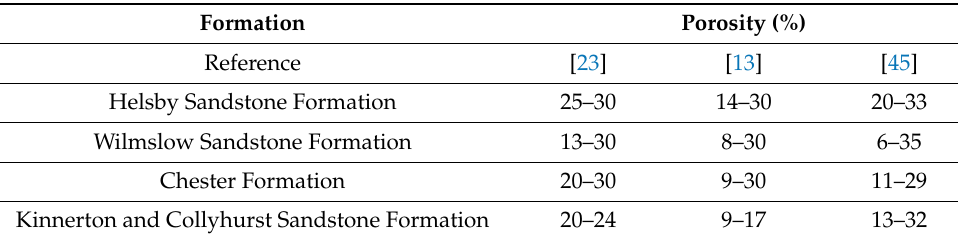
Table 2. Table of porosities taken from a range of literature sources. Developed from Allen et al. [45], Downing and Gray [13], Plant et al.